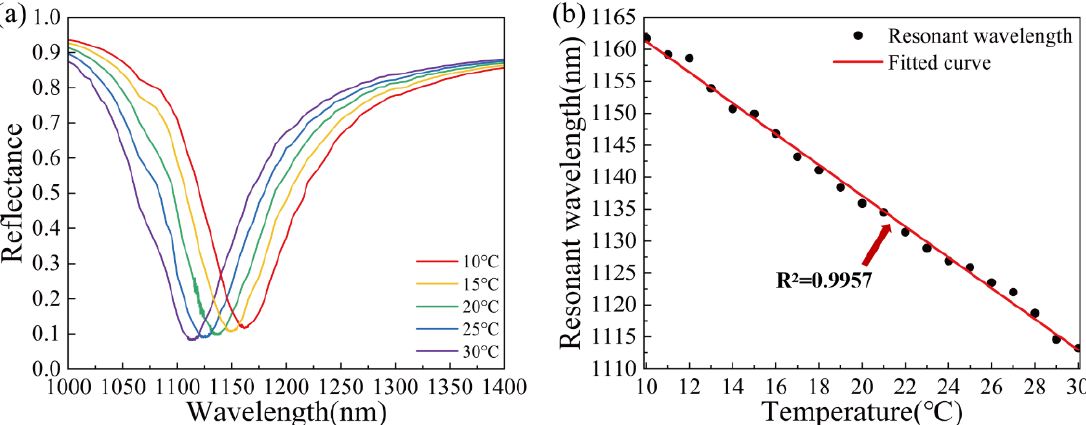
Figure 10. ( a ) The reflectance curve of optimized TiO 2 (film)-Au-TiO 2 (nanorods) triple SPR sensor in the 10–30 °C range and ( b ) SPR wavelength corresponding to temperature for every 1 °C in the 10–30 °C range and linear fitting.